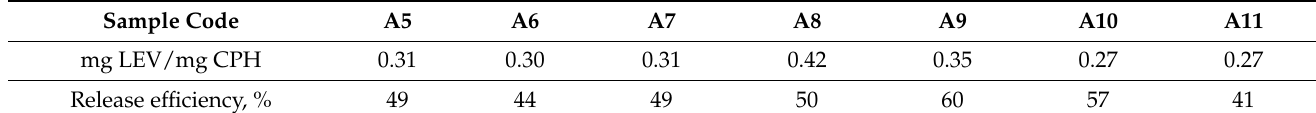
Table 4. Released drug and efficiency.